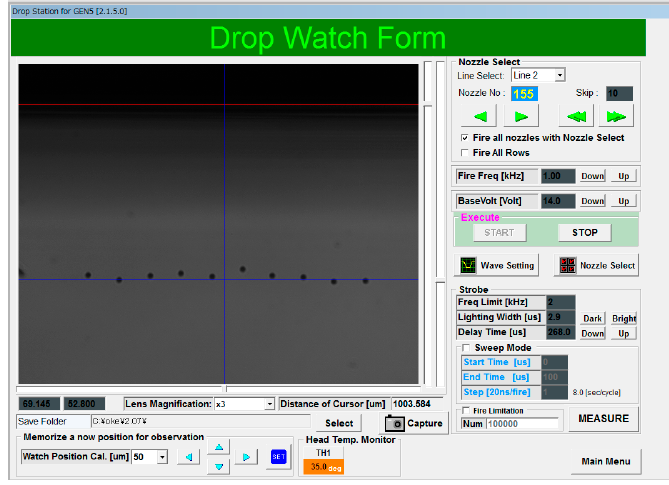
Figure 5. Drop watch from input waveform.